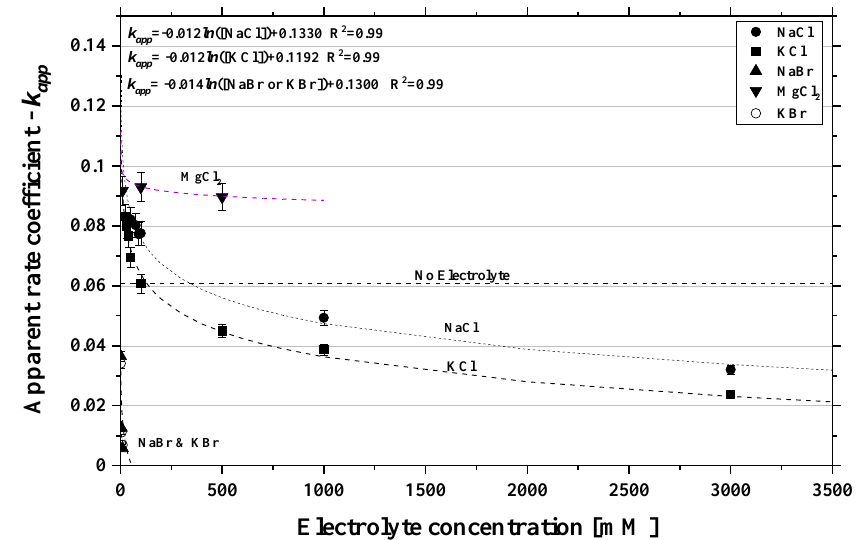
Figure 3. Apparent rate coefficients ( k app ) as a function of electrolyte concentration (electrolytes are represented by different symbols). Dashed plots represent a logarithmic regression fitting as described by the equations inside the figure.